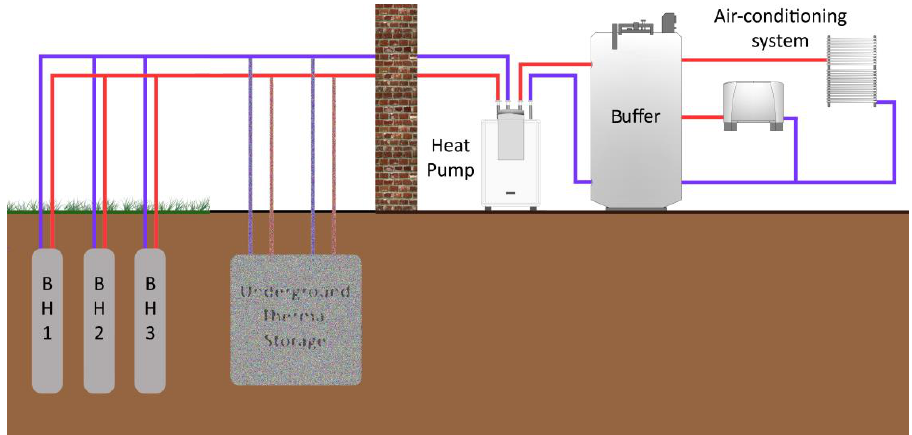
Figure 1. The prototype layout: conventional mode.